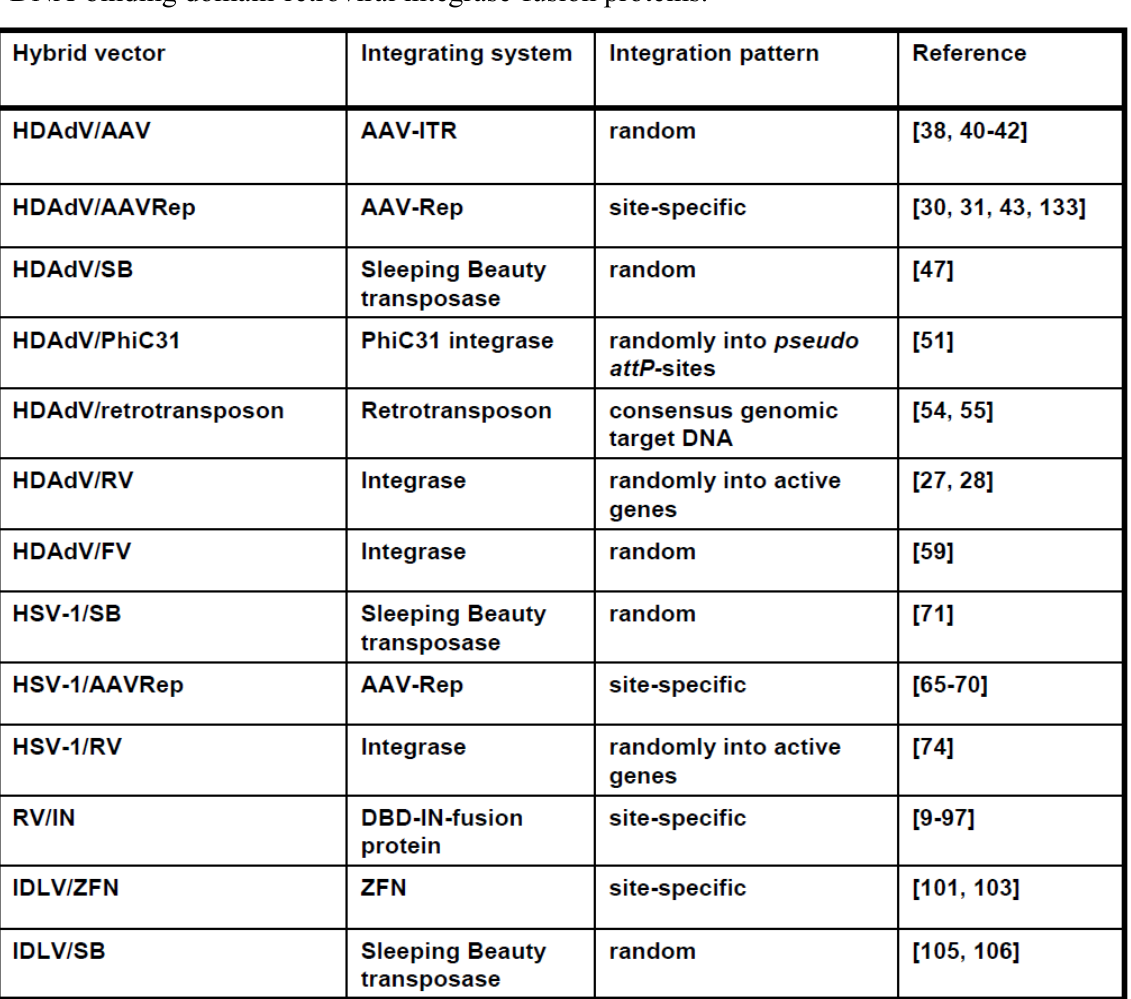
Table 2. Overview of currently used hybrid vector systems. The first column indicates the viral hybrid vector system for stable integration into the host genome. For each system the integration system and the integration pattern (random versus site-specific) are mentioned and the respective references are summarized. HDAdV: helper-dependent adenovirus, SB: Sleeping Beauty transposase, PhiC31: bacteriophage-derived integrase PhiC31, AAV: adeno-associated virus, AAV-Rep: AAV-derived Rep coding sequence responsible for site-specific integration into AAVS1, ZFN: zinc-finger nuclease, DBD-IN fusion proteins: DNA-binding domain-retroviral integrase-fusion